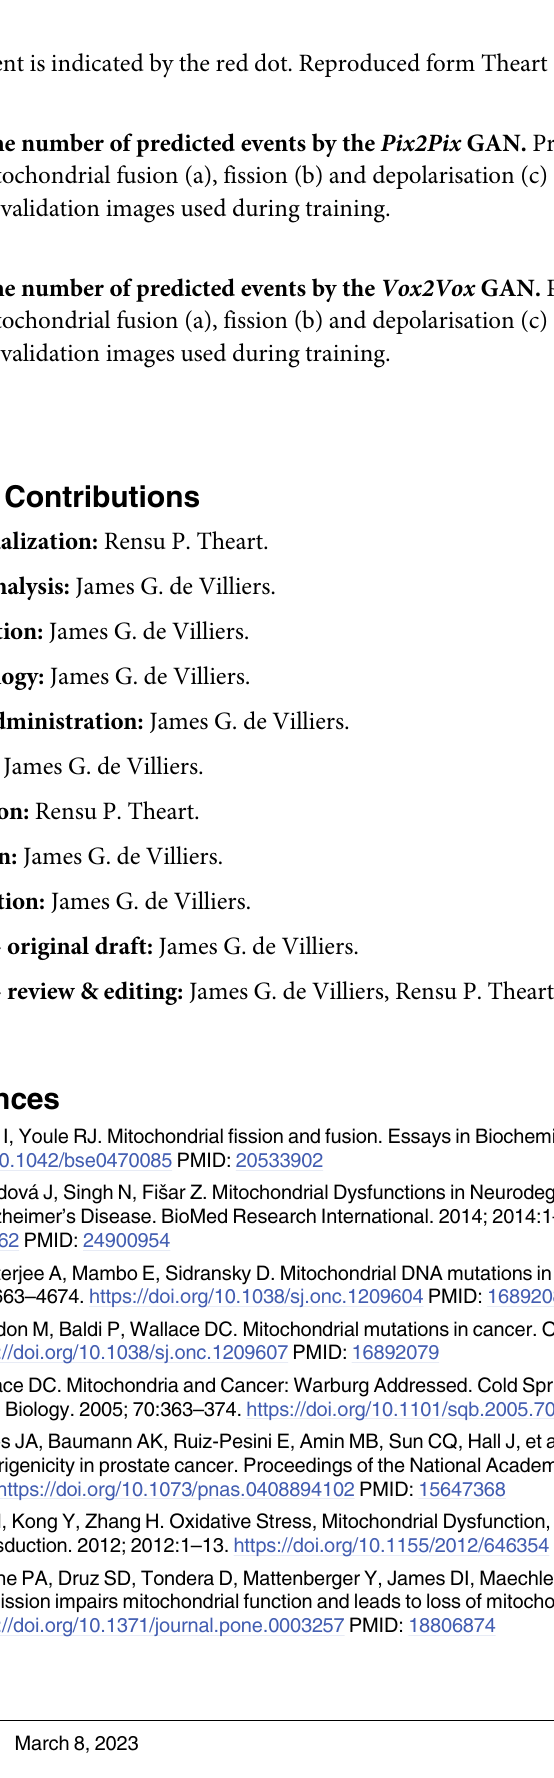
S3 Fig. The number of predicted events by the Pix2Pix GAN. Predicted and correctly pre- dicted mitochondrial fusion (a), fission (b) and depolarisation (c) events by the Pix2Pix GAN for the 19 validation images used during training. S4 Fig. The number of predicted events by the Vox2Vox GAN. Predicted and correctly pre- dicted mitochondrial fusion (a), fission (b) and depolarisation (c) events by the Vox2Vox GAN for the 19 validation images used during